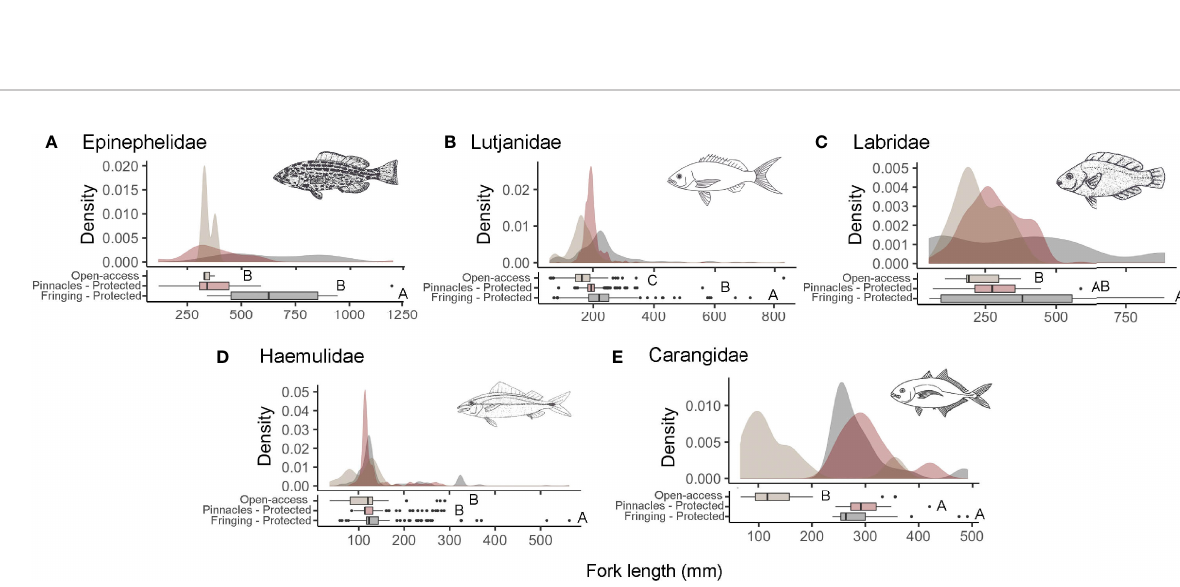
FIGURE 6 | Kernel density plots and boxplots with Kruskal – Wallis post-hoc test results (p-values < 0.05) for fi sh fork length (mm) (letters) for important fi sheries target families: Epinephelidae (A) , Lutjanidae (B) , Labridae (C) , Haemulidae (D) and Carangidae (E) . In the kernel density plots, the gray color represents the Fringing Reefs, red the Pinnacles Reefs, and beige Coastal Reefs. Fish drawings based on Carvalho-Filho et al.